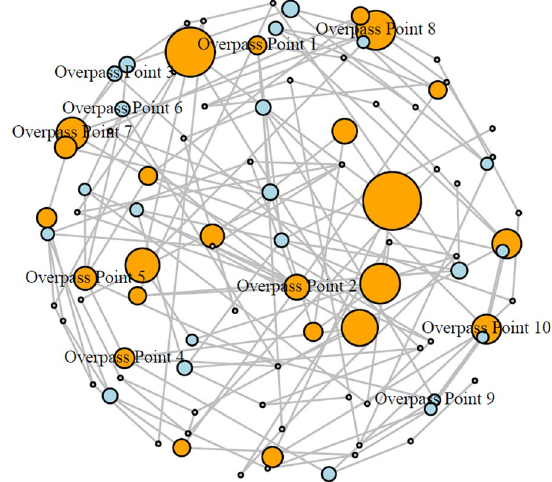
Fig. 5 Betweenness Centrality of Nodes. Source: Authors’ elaboration from iGraph R Package. Orange coloured nodes indicate those nodes whose betweenness centrality value falls within the fourth 4 th quartile of the distribution, while nodes whose betweenness value falls between the 2nd and 3rd quartiles are indicated in light blue. In addition, the size of the nodes reflects the value of the centrality indicator. All other nodes are indicated in grey and with fixed